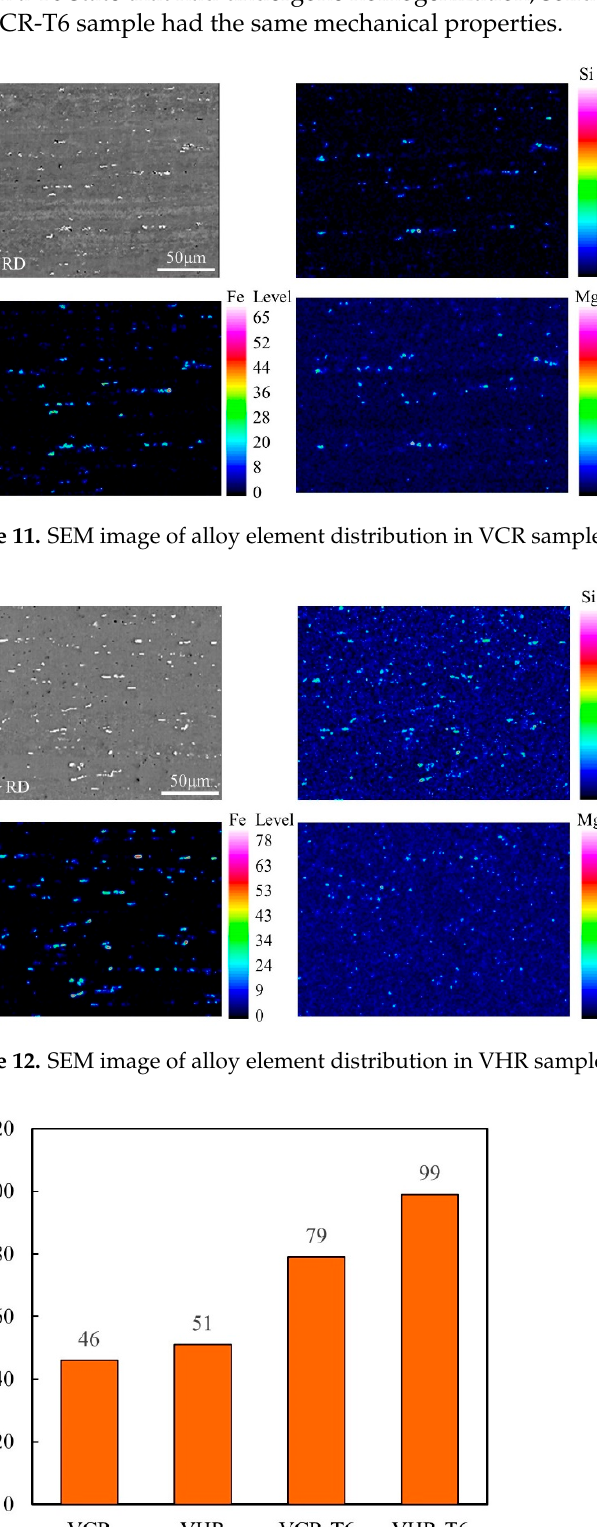
Figure 14. Comparison of tensile properties. 4. Discussion For AA6063 aluminum alloy, the microstructure of the billet and morphology and distribution of the precipitated phase greatly affect its mechanical properties. Therefore, the billet prepared by the traditional DC casting process needed to undergo a prolonged homogenization heat treatment to improve the severe segregation. Homogenizing heat treatment can make the coarse second phase of segregation in the billet completely dis- solve or transform, eliminate the adverse effects of the coarse Mg 2 Si phase and hard β - Al 5 FeSi phase, form a supersaturated solid solution, and precipitate some fine dispersed strengthened phases, so as to improve the mechanical properties of the material. The re- sults of this paper show that AA6063 aluminum alloy can be fabricated by the VC process and directly rolled without homogenizing heat treatment to obtain improved mechanical properties. On the one hand, the billet had a high cooling rate during the whole solidifi- cation process due to the direct water spray and relatively small thickness of the slabs, and finally formed a structure completely composed of equiaxed grains, which gave the billet uniform mechanical properties. On the other hand, rapid cooling reduced the den- drite spacing and precipitated phase size of the billet and improved the solution degree of the alloy elements. The small dendrite spacing was beneficial to improve the uniformity of alloying elements in the casting billet, and the uniform distribution of high solid solu- tion structure was beneficial to the uniform and dispersed precipitation of the strength- ened phase during the aging process. All of these factors are conducive to improving the mechanical properties of the product. A sufficiently large cooling rate has a positive effect on the element uniformity of the billet, which is similar to the partial effect of